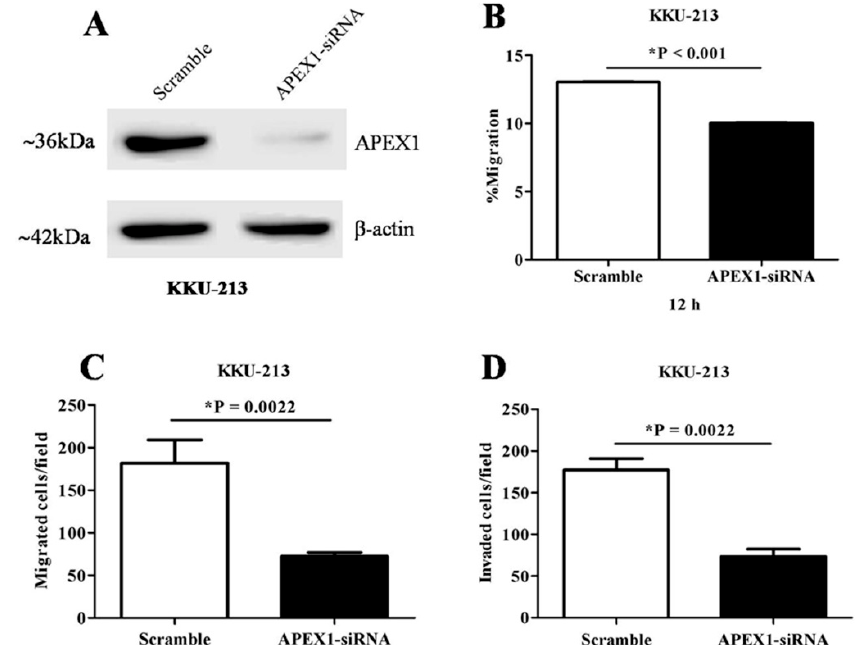
Figure 7. The e ff ects of APEX1 gene-silencing on the CCA cell line KKU-213. ( A ) Western blot analysis showing suppressed APEX1 protein expression after gene silencing. β -actin was used as a control for loading protein. ( B ) Suppression of cell motility after APEX1 gene-silencing in wound healing model. ( C ) Suppression of cell migration after APEX1 gene-silencing in Transwell-migration assay. ( D ) Suppression of cell invasion after APEX1 gene-silencing in Matrigel-invasion assay.